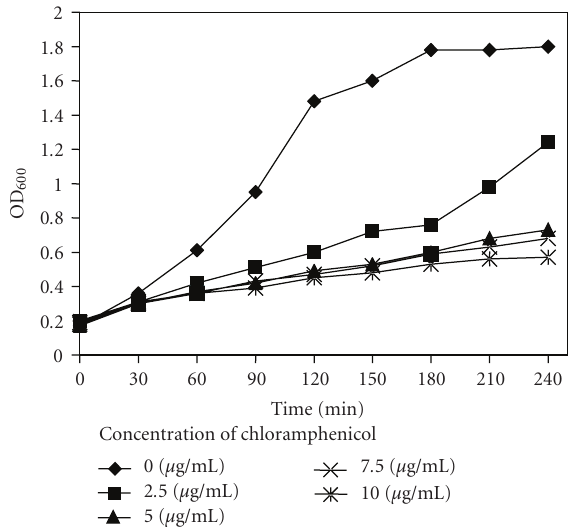
Figure 1: Growth of E. faecalis V583 treated with chloramphenicol, measured spectrophotometrically (600 nm). Cell samples used for the microarray hybridizations were collected immediately after addition of chloramphenicol (2.5 μ g/ μ l), after 90 min and after 180